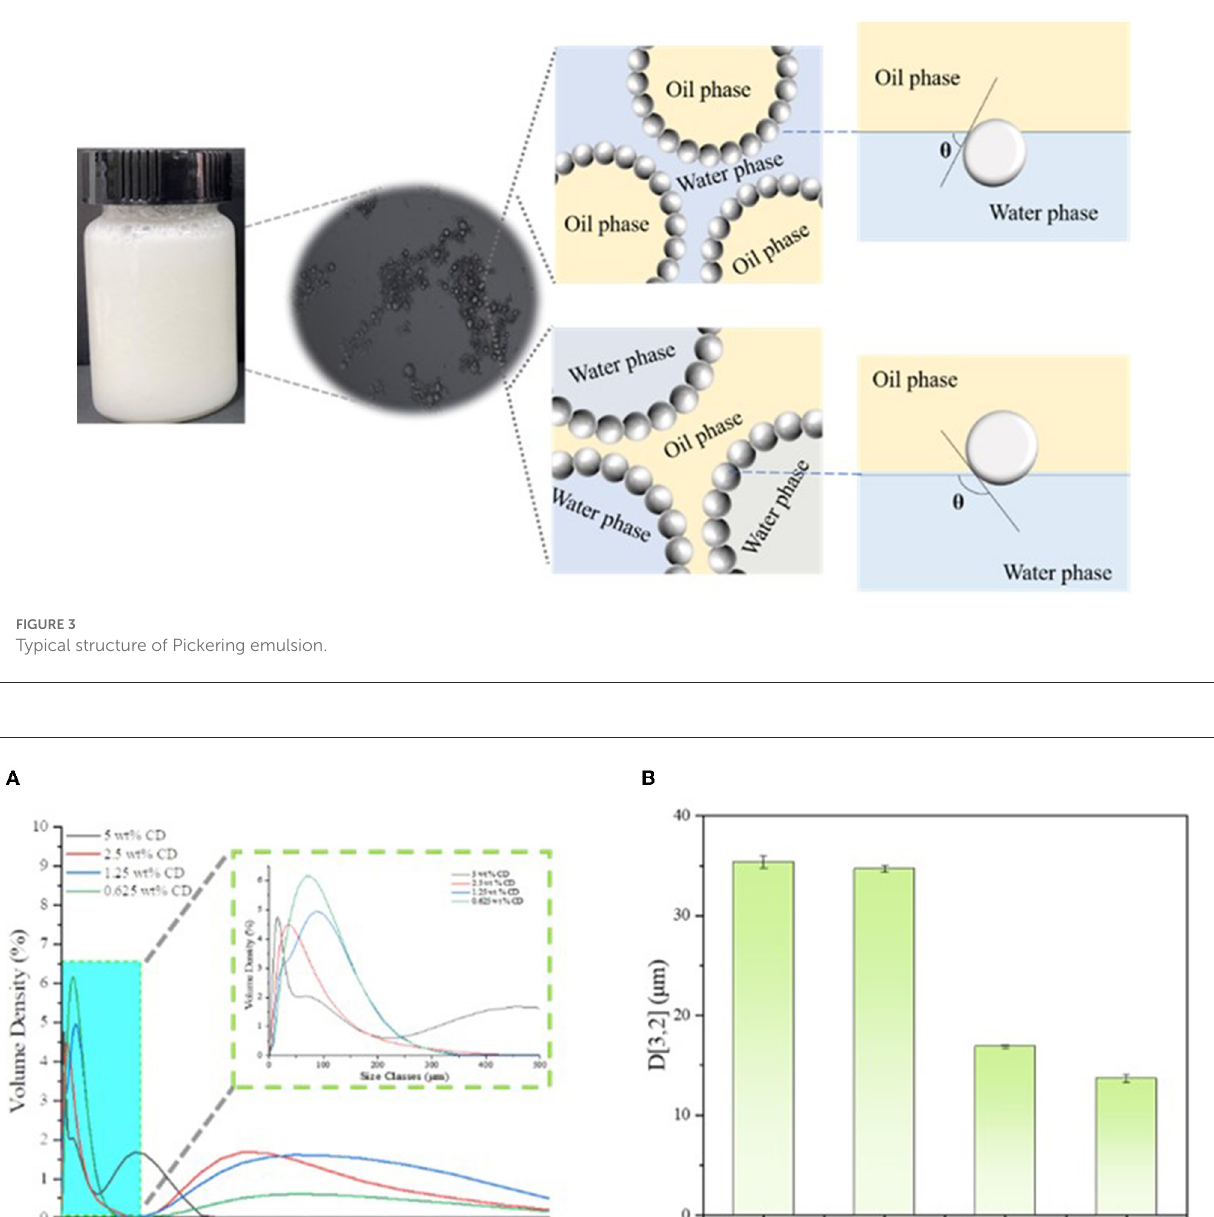
FrontiersinNutrition